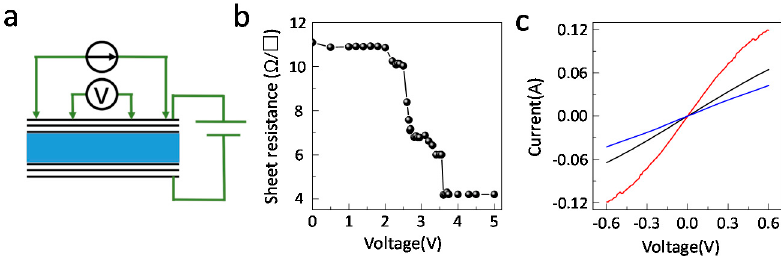
Figure 5. The sheet resistance of ionic liquid intercalated multilayer graphene. ( a ) Schematic of the in-situ sheet resistance measurements system. ( b ) The dependence of the sheet resistance on the intercalated bias voltage. ( c ) I-V curves of pristine (black), intercalated (red) and deintercalated (blue) multilayer graphene.